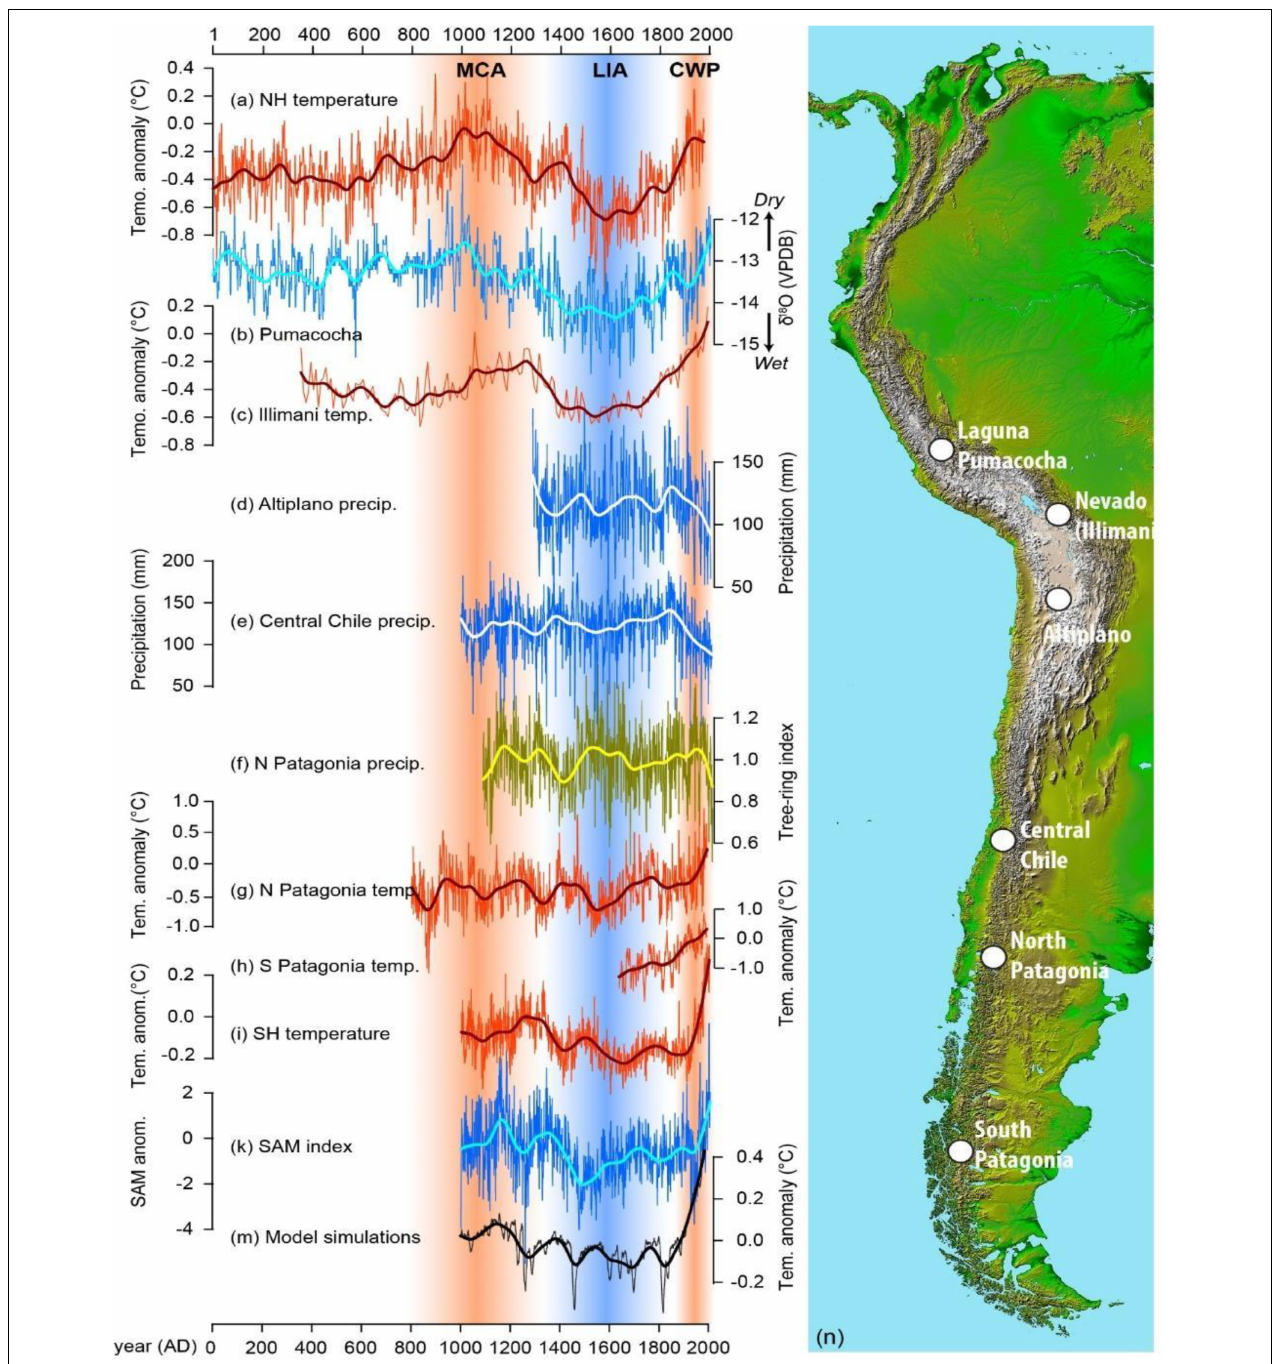
FIGURE 1 | Climatic variations along the Andes during the last 2000 years and their relationships with hemispheric and global forcings of long-term climate variability. (A) Reconstruction of NH temperature anomalies (Moberg et al., 2005), (B) The Pumacocha δ 18 O record of SAMS intensity (Bird et al., 2011); (C) Reconstruction of tropical South American temperature anomalies (Kellerhals et al., 2010); (D) Annual precipitation reconstruction in the South American Altiplano (Morales et al., 2012); (E) Reconstruction of winter–early summer (June–December) normalized precipitation anomalies from Central Chile (Garreaud et al., 2017); (F) Precipitation-sensitive chronology from Austrocedrus chilensis in northern Patagonia (Villalba et al., 2012); (G) Summer (December-February) temperature reconstruction in northern Patagonia (Villalba, 1990 and updates); (H) Annual temperature variations in southern Patagonia (Villalba et al., 2003); (I) Ensemble mean temperature reconstruction for the SH relative to the millennium mean (Neukom et al., 2014); (K) Summer (December-March) reconstruction of the Southern Annular Mode (Dätwyler et al., 2018); (M) Twenty-four member climate model ensemble for temperature variability in the SH (Neukom et al., 2014). To emphasize the long-term variability, all records are also shown in a smoothed version using a 128-year spline filter; (N) Map of the western part of South America showing the location of the proxy records and the geographical areas discussed in the text.